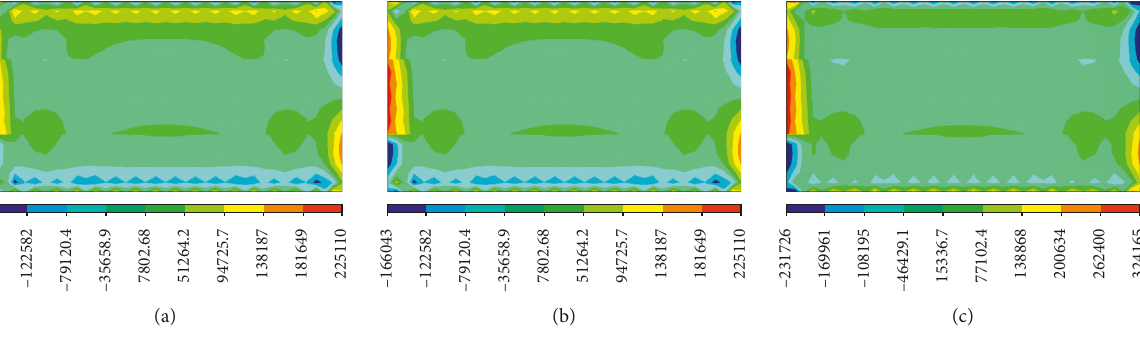
50%. (b) P 90%. (c) P (cid:31) (cid:31) (cid:31)